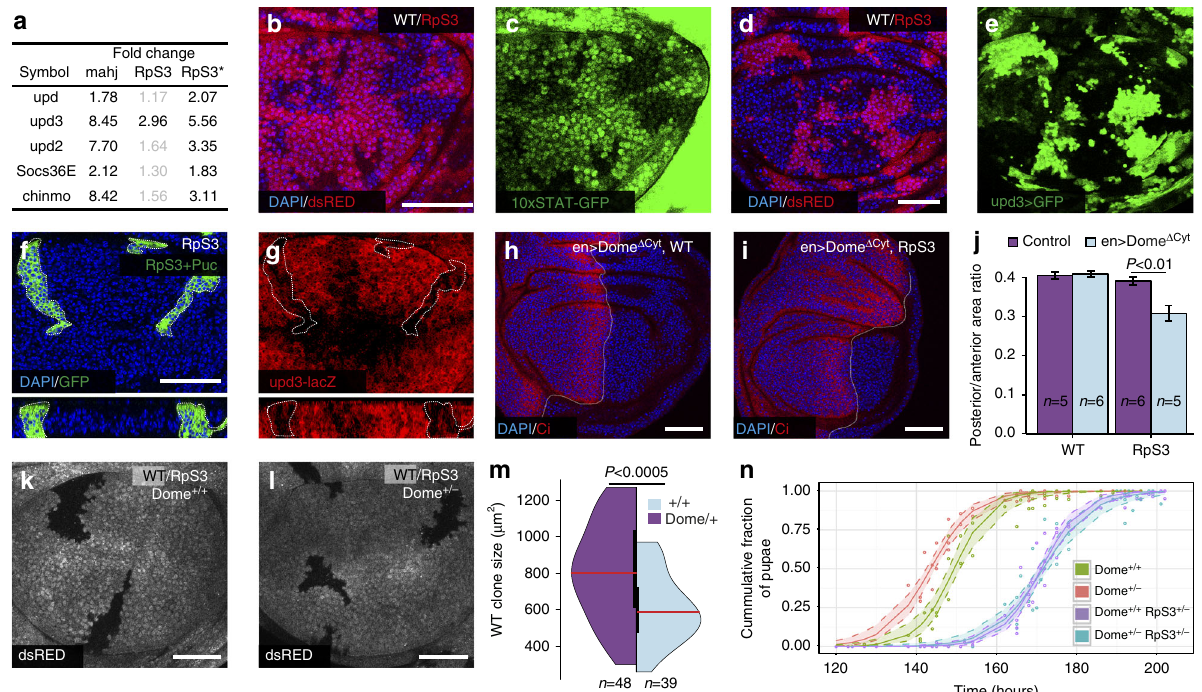
Fig. 4 JAK/STAT activation is required for normal RpS3 + / − tissue growth and for competition -induced overproliferation of winner cells. a List of known JAK/STAT targets and regulators differentially expressed in the indicated prospective loser genotypes (fold changes with false discovery rate > 0.1 are in grey ). b , c JAK/STAT reporter 10XSTAT-GFP expression in wing discs mosaic for RpS3 + / − cells (ds-RED-positive) and WT cells (ds-RED-negative). d , e upd3 > Gal4 reporter driving the expression of GFP in wing discs mosaic for RpS3 + / − cells (ds-Red positive) and WT cells (ds-RED negative). f , g upd3 -LacZ reporter activity ( red , g ) in RpS3 + / − wing discs harbouring GFP-labelled clones ( f ) that overexpress puc . Both xy ( top ) and xz sections ( bottom ) of the same wing disc are presented with clones outlined ( white dotted line ). h , i Expression of dominant negative JAK/STAT receptor Dome (Dome Δ Cyt ) in the P compartment (labelled by absence of Ci ( red )) of wild-type (WT) ( h ) or RpS3 + / − wing discs ( i ). j Quanti fi cation of P/A compartment wing pouch ratios of WT or RpS3 + / − wing discs expressing or not Dome Δ Cyt in the P compartment, as indicated; P values according to Wilcoxon rank sum test. k , l Wing disc harbouring WT clones (dsRED negative) in an RpS3 + / − Dome + / + background ( k ) or in an RpS3 + / − Dome + / − background ( l ). m Size distribution of WT clones induced in discs of genotypes as in k , l , as indicated, P values according to Wilcoxon rank sum test. n Developmental timing until pupariation represented as cumulative fraction of pupae over time for larvae of the indicated genotypes. Data were fi tted to a sigmoid curve; the shaded area represents 99% con fi dence intervals for the fi t. Each condition consists of at least fi ve repeats of n > 17 larvae. Detailed genotypes for each